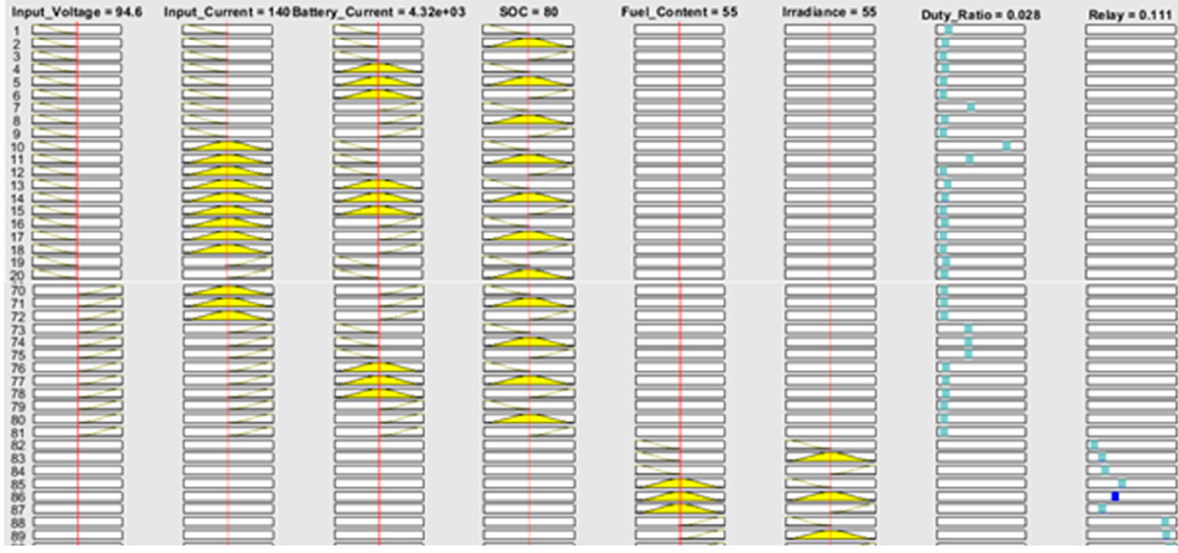
Figure 33. Output variable relay membership functions.